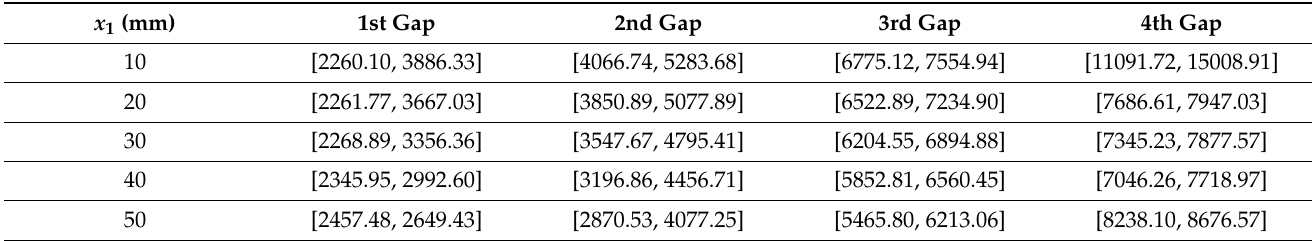
Table 3. Multiple bandgaps with different values of the square hollow side length x 1 .